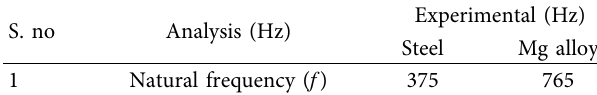
Table 10: Natural frequency values of both materials.